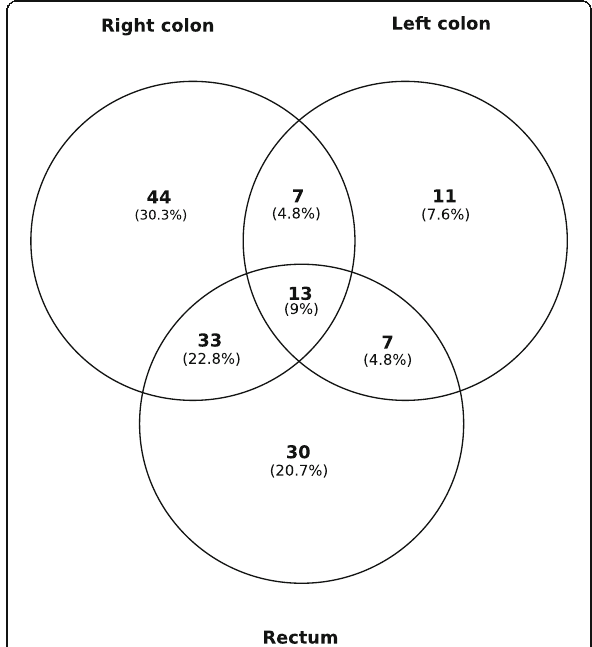
Fig. 3 Venn diagram of plasma proteins whose levels changed during CRC progression in all